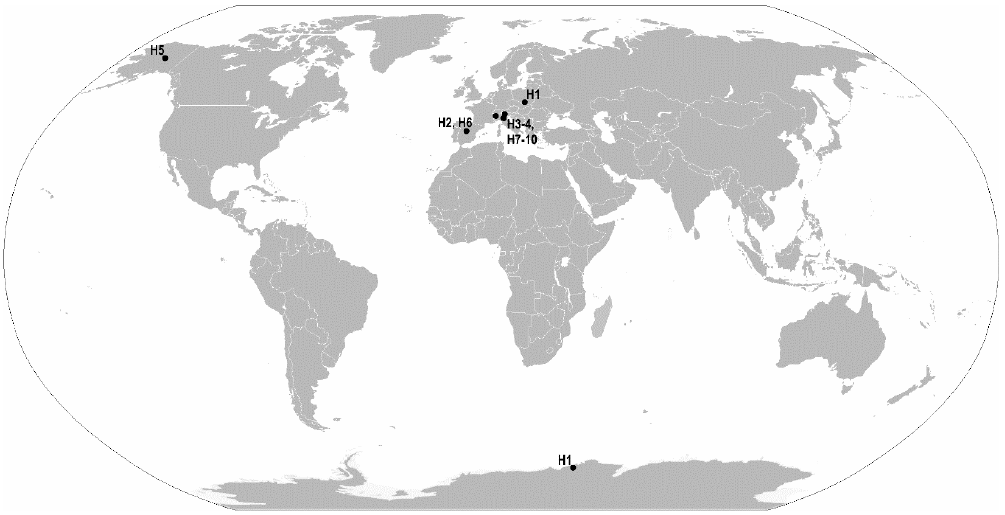
Figure 10. A World map with indicated haplotypes of Paramacrobiotus fairbanksi Schill, Förster, Dandekar and Wolf [25] found in different localities.